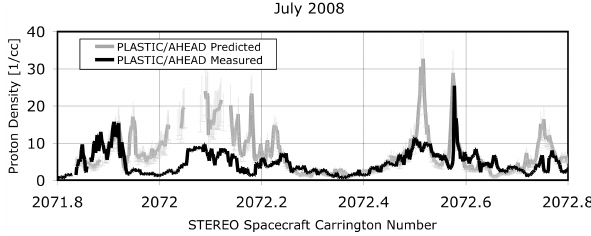
Fig. 4. Predicted and observed solar wind speed at PLAS- TIC/AHEAD during July 2008. An uncertainty of ± 100km/s on the predicted speed is shown with grey shading, while the observed values are given by the solid black curve.